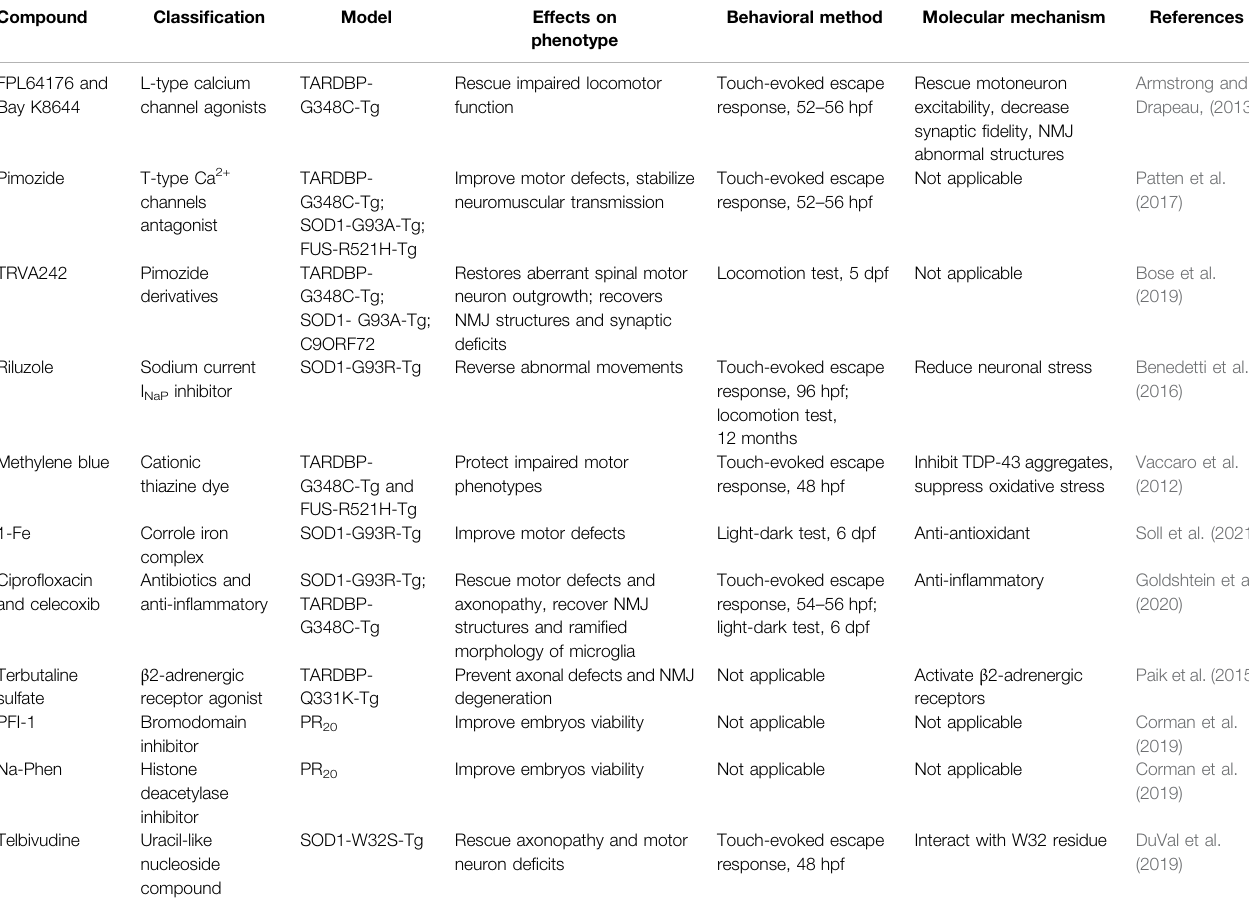
TABLE 3 | Drugs identi fi ed for ALS treatment in zebra fi sh models.